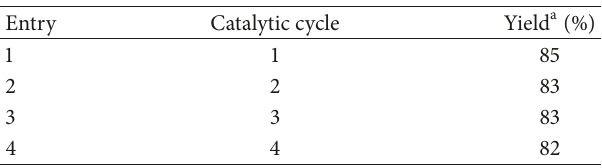
Table 3: Effect of catalyst reuse cycles on 1-bromo-2-phenoxyethane yields